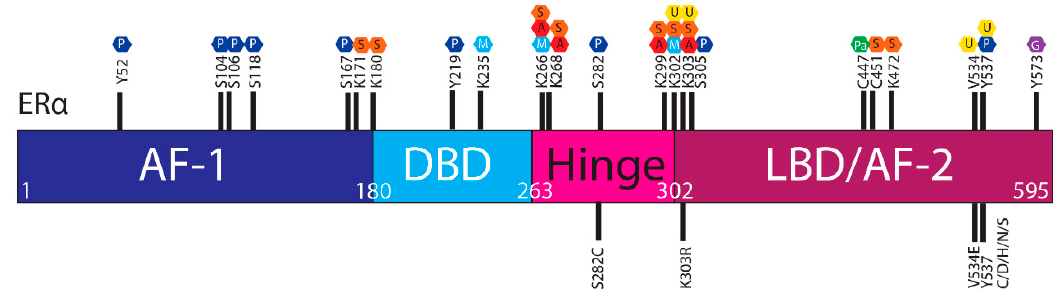
Figure 3. Post translational modifications of ER α . The ER α functional domains include: Activation Function 1 (AF-1) (purple), DNA Binding Domain (DBD) (blue), hinge (pink), Ligand Binding Domain (LBD) and AF-2 (plum). At the top of the schematic are known sites PTMs of ER α ; phosphorylation (P, dark blue), SUMOylation (S, orange), methylation (M, light blue), acetylation (A, red), ubiquitylation (U, yellow), pamiltoylation (Pa, green) and gycosylation (G, purple). At the bottom are PTM sites a ff ected by ESR1